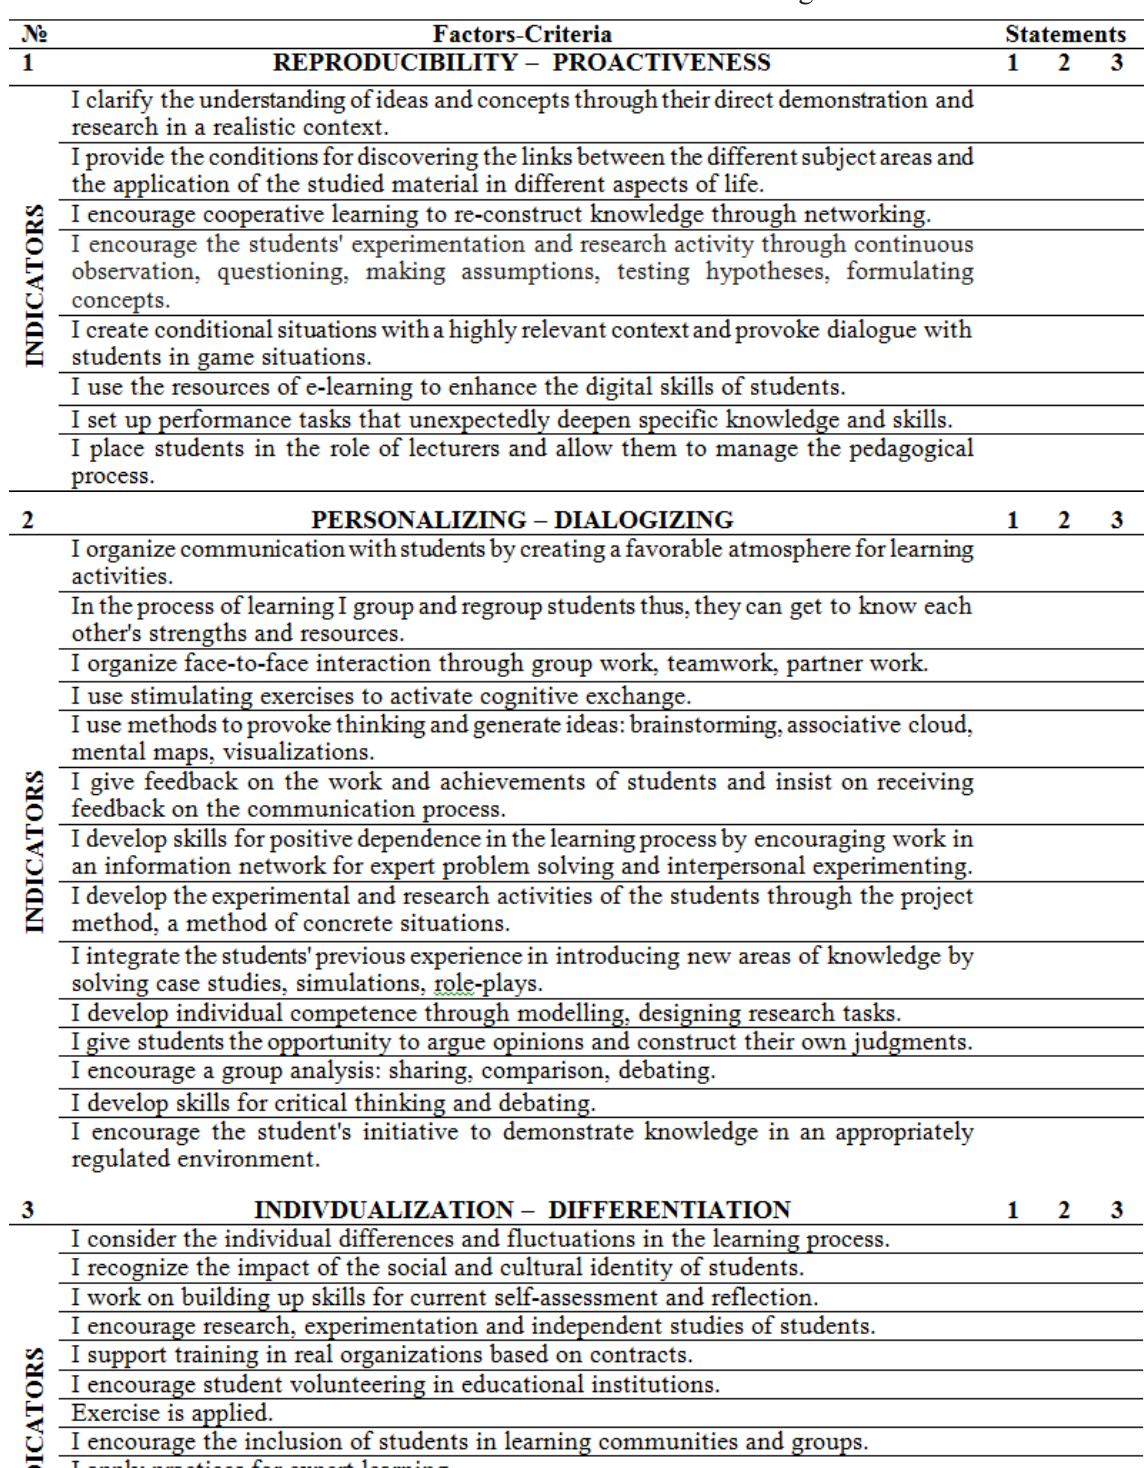
Table 2. Matrix for Teacher Self-Assessment of the Learning